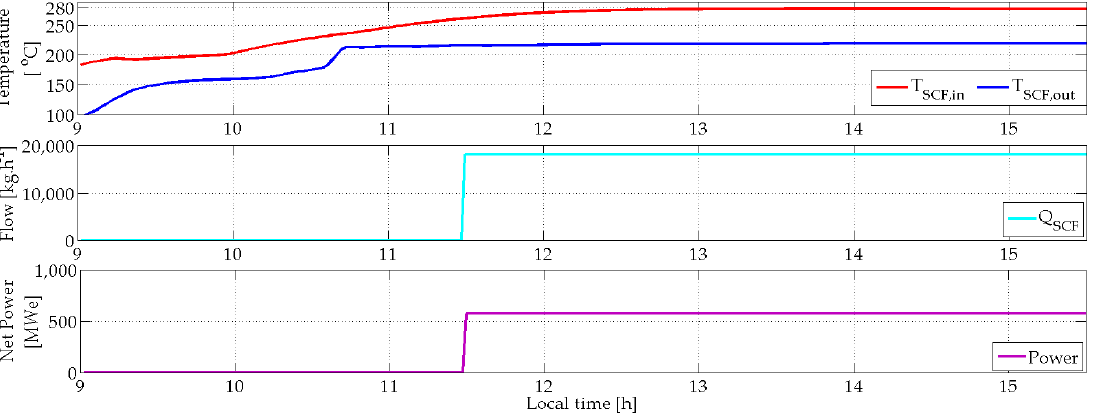
Figure 9. Input and output temperatures, workflow and power delivered by the Distributed Collector Systems (DCS) .